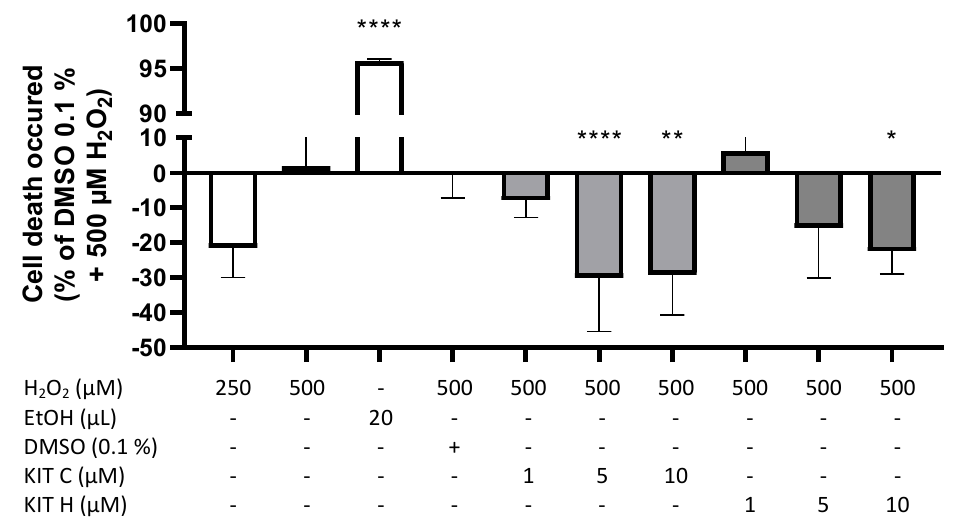
Figure 4. Effects of KIT C (light grey) and KIT H (dark grey) on H 2 O 2 -induced cell death in the ROS-MTT assay in SK-N-SH cells. SK-cells were stimulated as described in material and methods. After 24 h, cell death was measured by change in color due to MTT-oxidation. Values are presented as the mean ± SD of at least three independent experiments. Statistical analysis was performed using one-way ANOVA with Dunnett’s post hoc tests with * p < 0.05, ** p < 0.01 and **** p < 0.0001 compared to 500 µM H 2 O 2 with 0.1% DMSO.